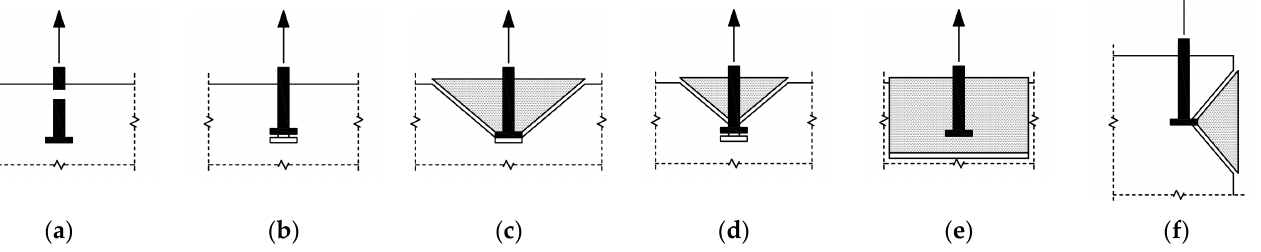
Figure 1. Failure modes under tensile loading: ( a ) steel failure; ( b ) pull-out or interface failure; ( c ) substrate cone; ( d ) combined pull-out and cone; ( e ) pull-out of one brick; and ( f ) lateral cone or blow-out failure. Adapted from [17].